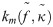
Plot of km(f˜,κ˜) (in real units of [s−1]) for three different values of scaled substrate stiffness κ˜.The red cross represents the value of the dimensionless scaled force f˜eq in cell equilibrium, corresponding to the steady state value of α. In the lowest plot (for stiff substrate), the red cross corresponds to a value of k
m = 0.01 s−1.